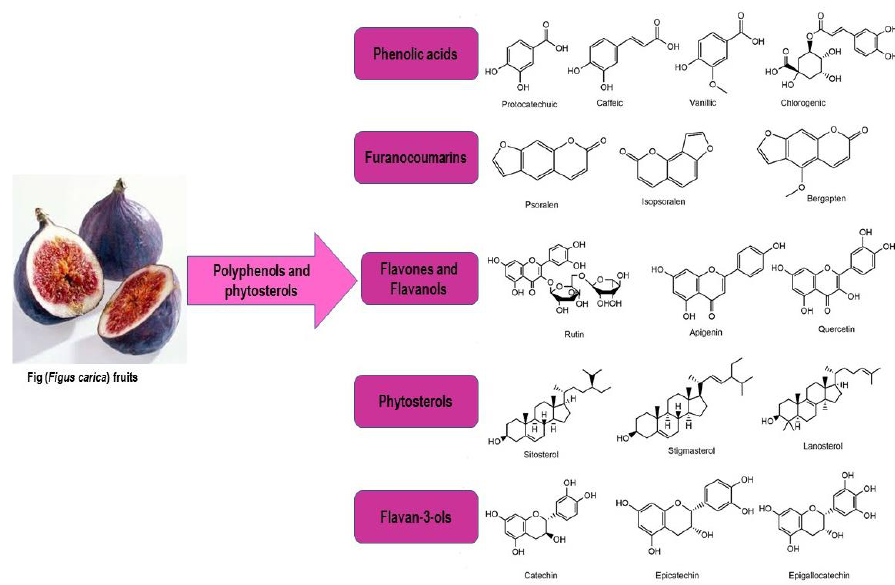
Figure 3. Polyphenols and phytosterols of fig.